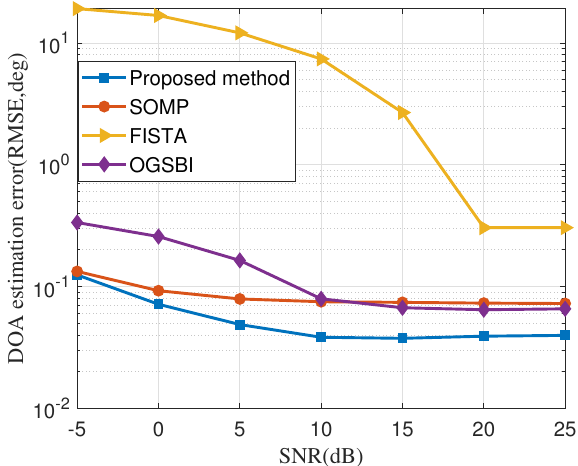
Figure 5. DOA estimation performance with different